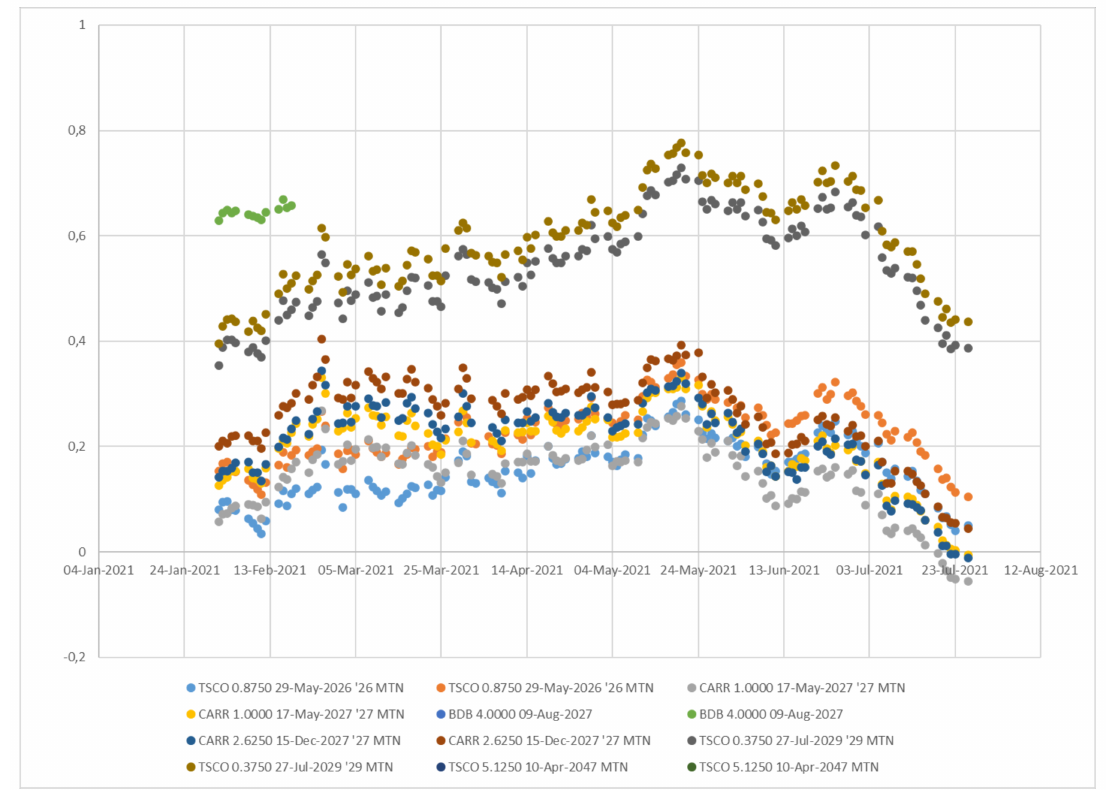
Figure 1. Yields of selected Tesco, Carrefour, and Metro bonds in period 29 January–26 July 2021 (in